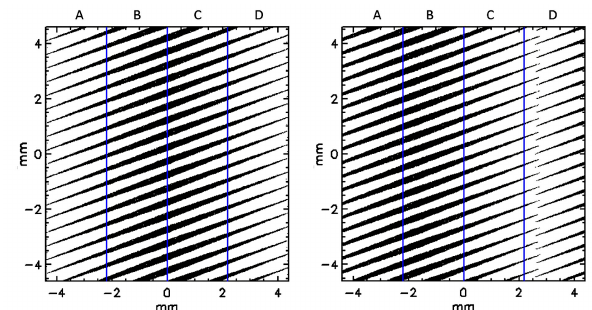
Figure 7. The example of modulation pattern of the subcollimator No. 32 for the point source located at the Sun center (left panel), and for the point source at heliographic coordinates 60” W, 60” N (right